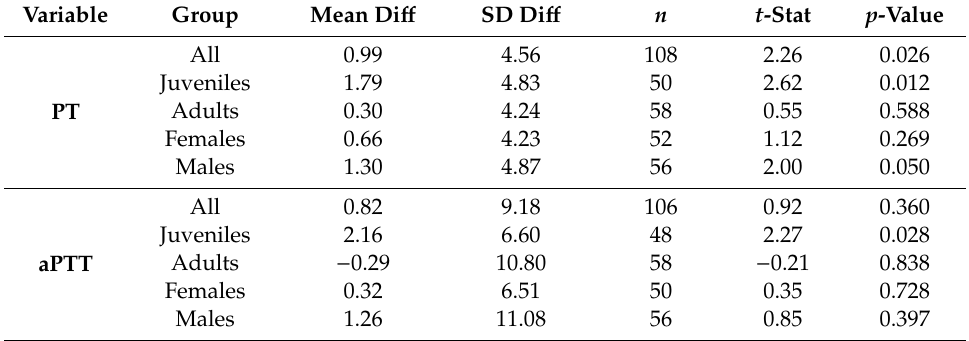
Table 2. Paired t -test results for 0.1 vs. 0.5 mL sample volume values for prothrombin time and activated partial thromboplastin time in seconds for all animals, or by age or gender.